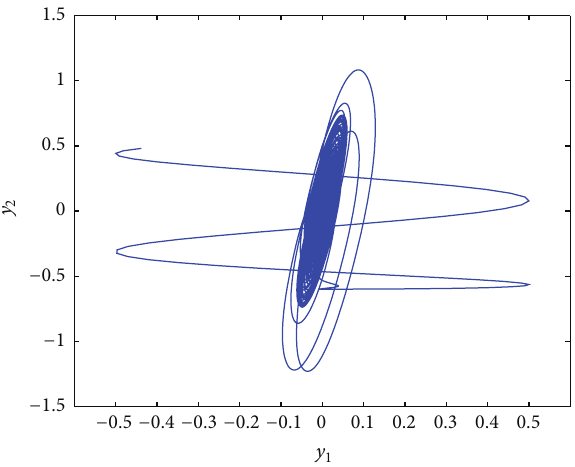
Figure 2: The chaotic behavior of slave system (2) with 𝑢(𝑡) = 0 . 0.7363 𝑊 = 10 −9 [ 2